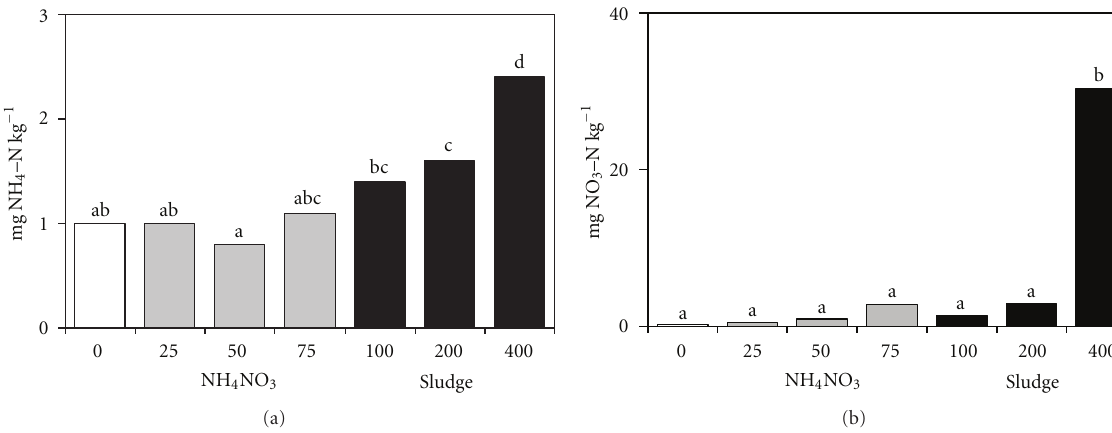
Figure 6: Greenhouse experiment. Soil ammonium-N and nitrate-N extracted from pots after 24 days of growth following amended with ammonium nitrate or sludge at rates shown in mgN kg − 1 dry soil. Controls received no amendment. Means with di ff erent letters (a, b, c, and d) are significantly di ff erent at the 5% probability